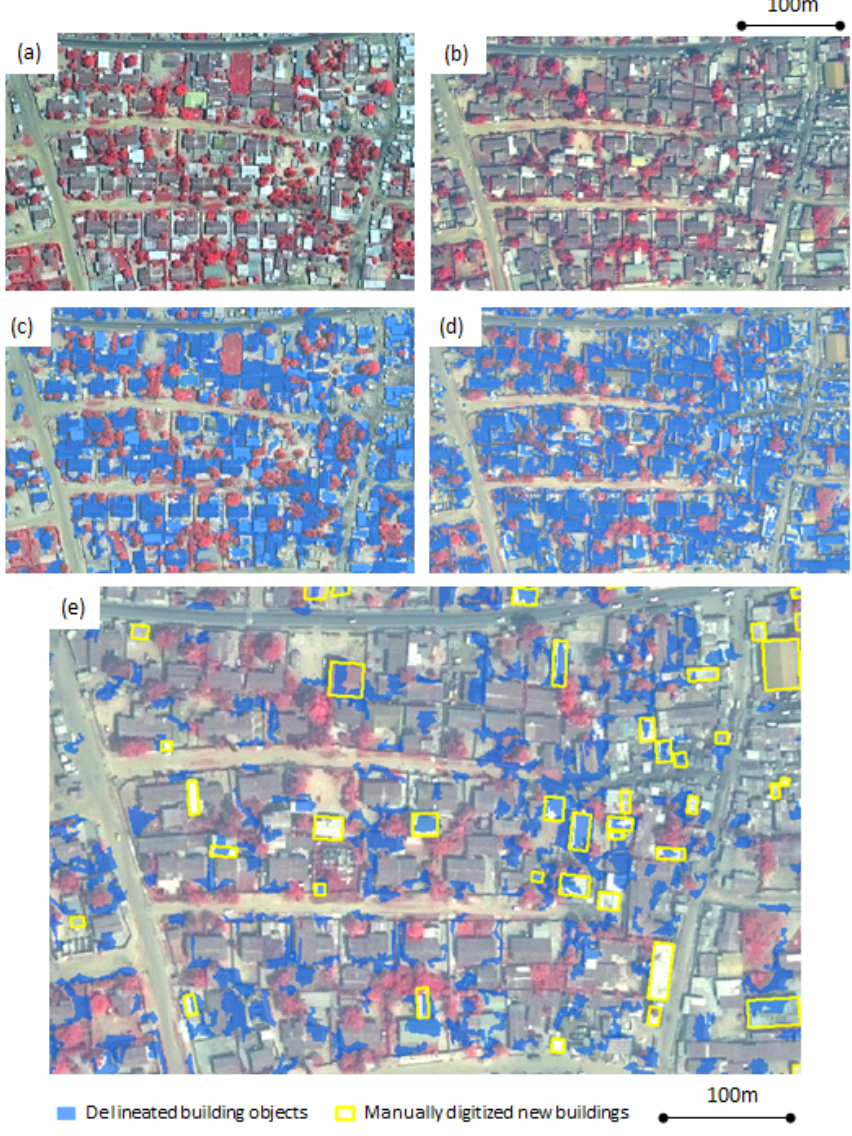
Figure 6. A subset of the delineated building map derived from the spectral/spatial contextual approach. (a) Pan-sharpened multispectral (PSMS) image of 2002. (b) PSMS image of 2010. (c) Objects classified as buildings in 2002 image (in blue). (d) Objects classified as buildings in 2010 image (in blue). (e) The delineated new buildings (in blue) using the post-classification comparison method. The actual new buildings are displayed in yellow. The over-classified building maps introduced errors into the final